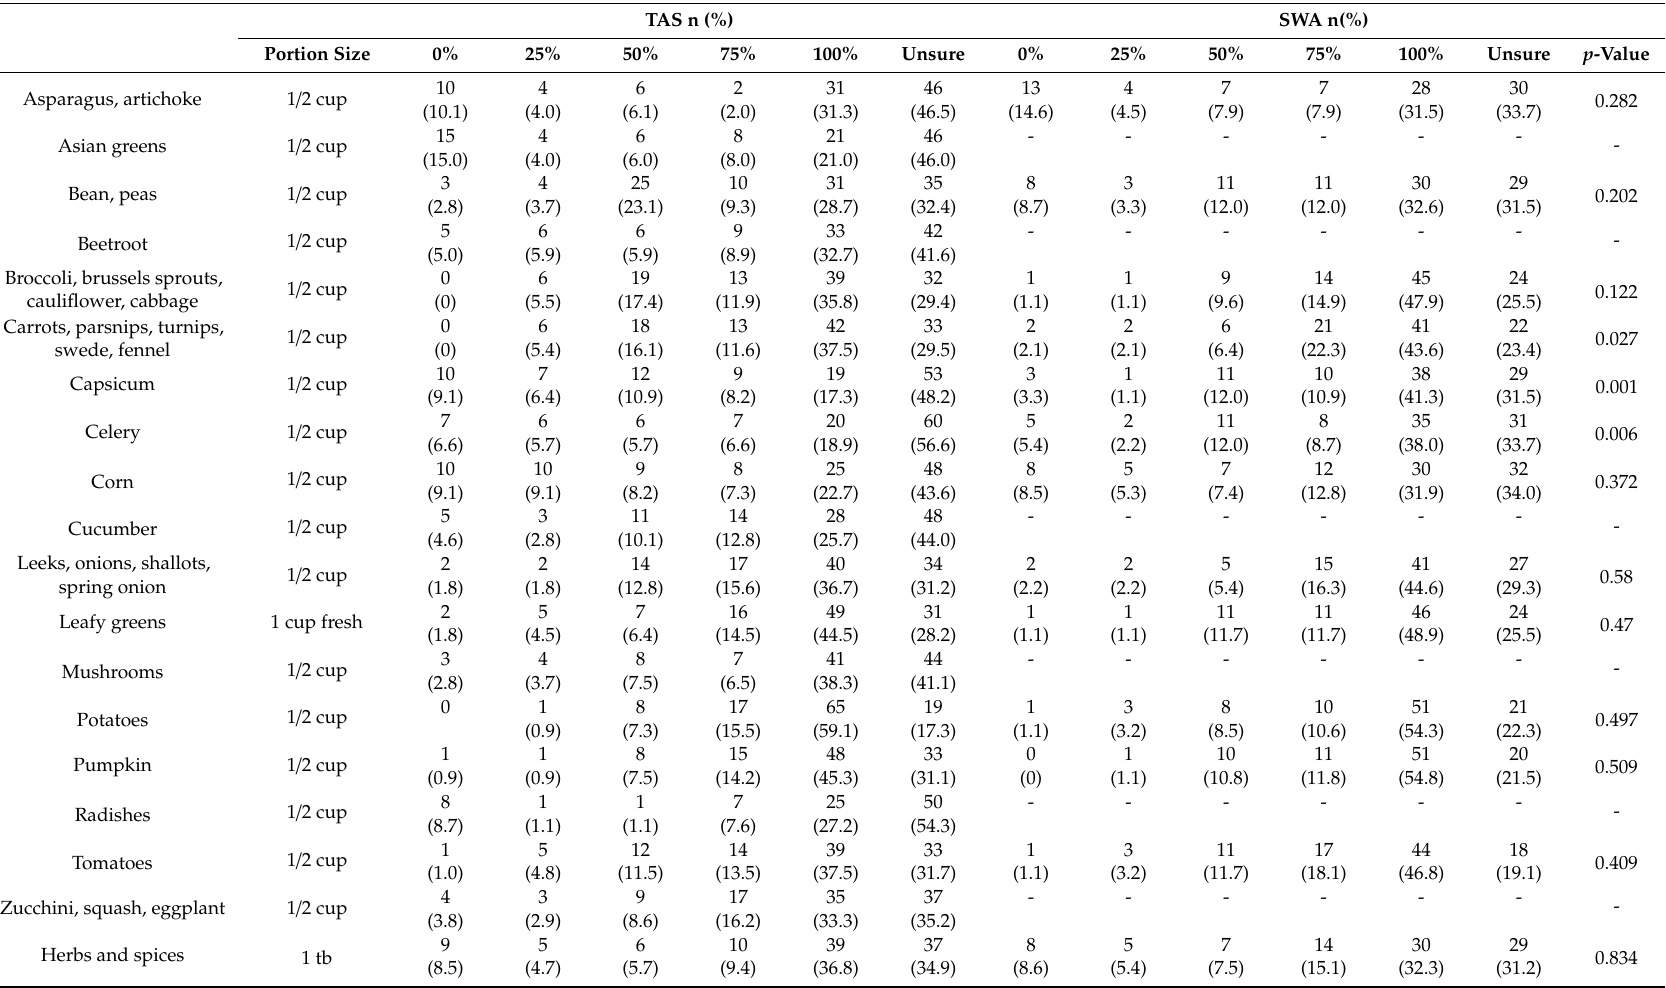
Table 4. Proportion of fruit and vegetables consumed by respondents in TAS and SWA estimated as being regionally